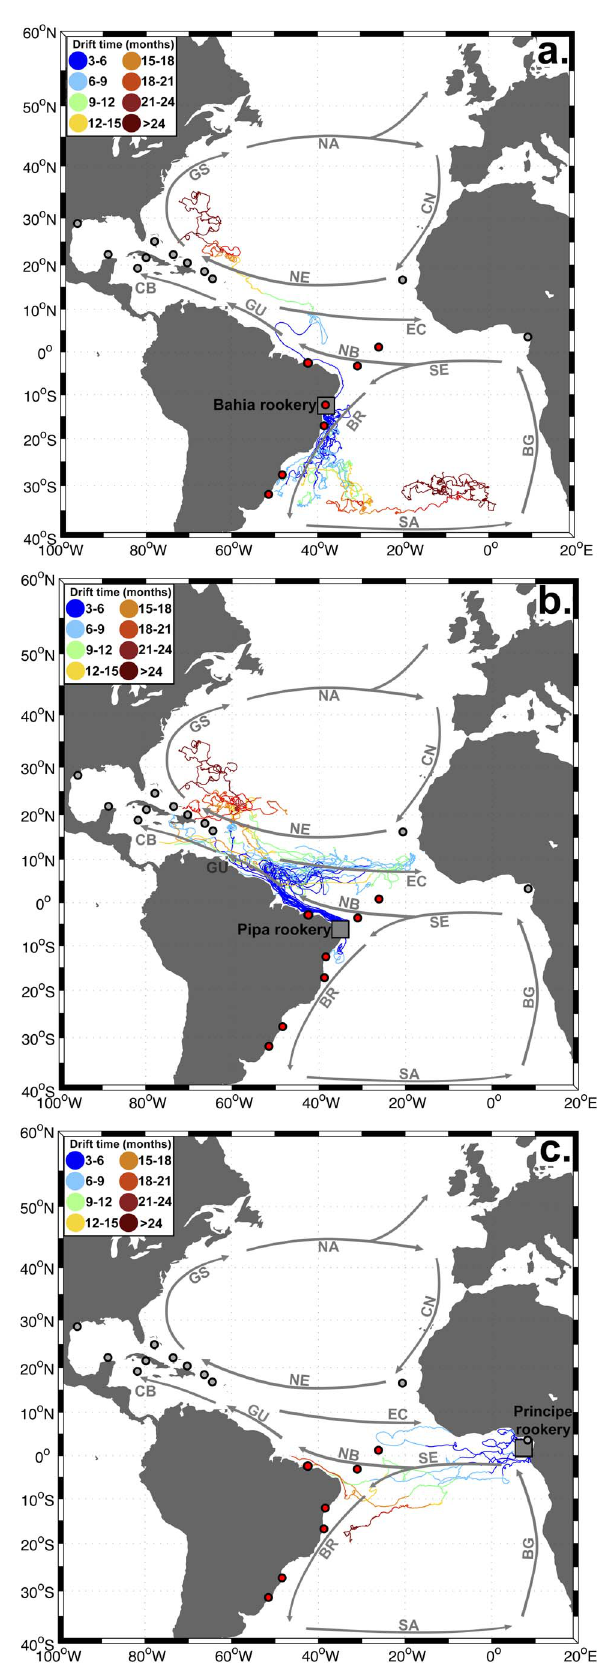
Figure 4. Pathways of drifters passing by Atlantic Ocean rookeries Bahia (a.), Pipa (b.) and Principe (c.). Drifter pathways for the other Atlantic rookeries are shown in Figure S3. Colors indicate drift time (in months). Grey squares = drifter release areas around the rookeries, red circles = Brazilian feeding grounds, grey circles = other Atlantic Ocean feeding grounds. Grey arrows indicate the flow of the major Atlantic Ocean currents: SE= South Equatorial Current, BR= Brazil Current, SA= South Atlantic Current (displaced to the North for illustrative purposes), BG= Benguela Current, NB= North Brazil Current, GU= Guiana Current, CB= Caribbean Current, EC= Equatorial Counter Current, NE= North Equatorial Current, GS= Gulf Stream, NA= North Atlantic Current, CN= Canary Current.